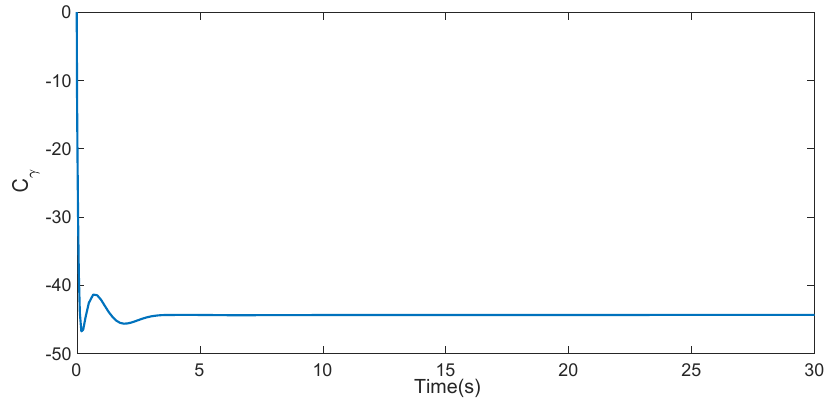
Figure 4. The γ C of node 1 agent. Figure 4. The C γ of node 1